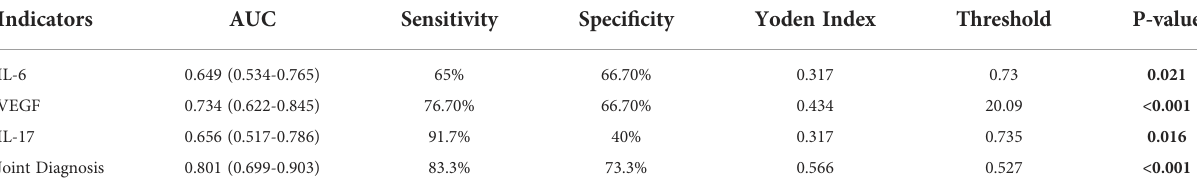
TABLE 3 ROC analysis of serum IL-6, IL-17 and VEGF in differentiating breast cancer from benign control group. Indicators